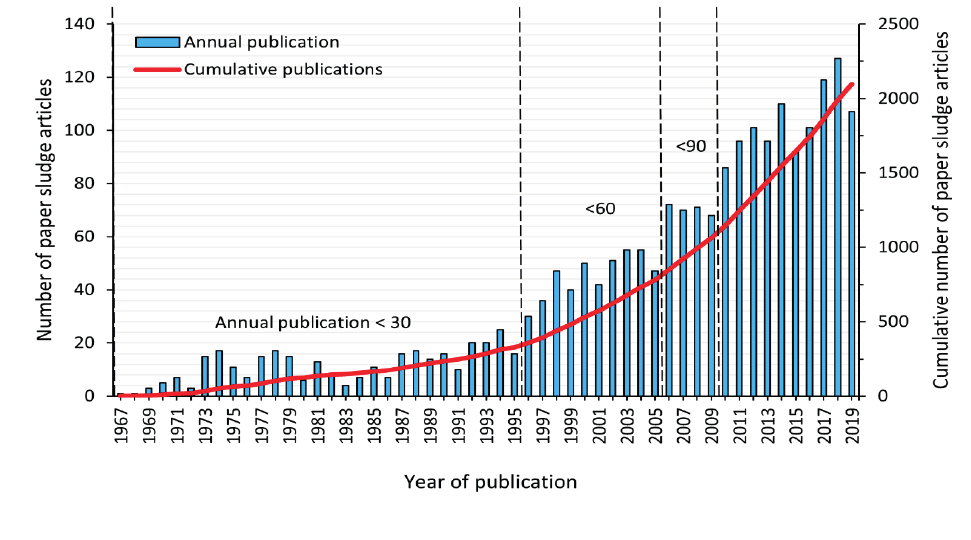
Fig. 2. Yearly and cumulative data of paper sludge published studies accessed throughout Scopus from 1967 to